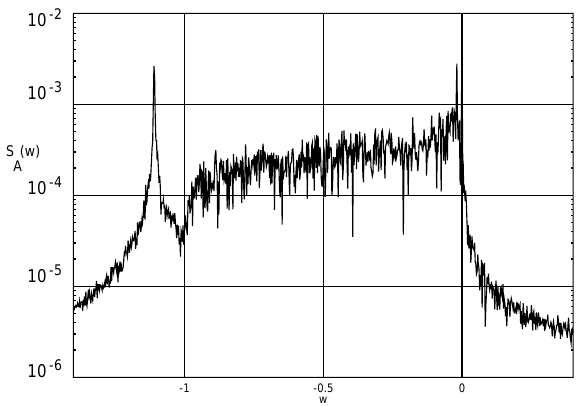
FIG. 1. Frequency spectrum of the bunch centroid motion (over 2 17 turns, N (cid:1) 10 4 macroparticles) for round beams with j x (cid:1) j y (cid:1) j (cid:1) 0.0034 and Q (cid:1) 0.32 . The horizontal axis gives the distance w to the unperturbed tune Q in units of j , i.e., w (cid:1) (cid:2) n 2 Q (cid:3)(cid:1) j . The vertical axis is the corresponding amplitude on a logarithmic scale. The p and s oscillation modes are clearly